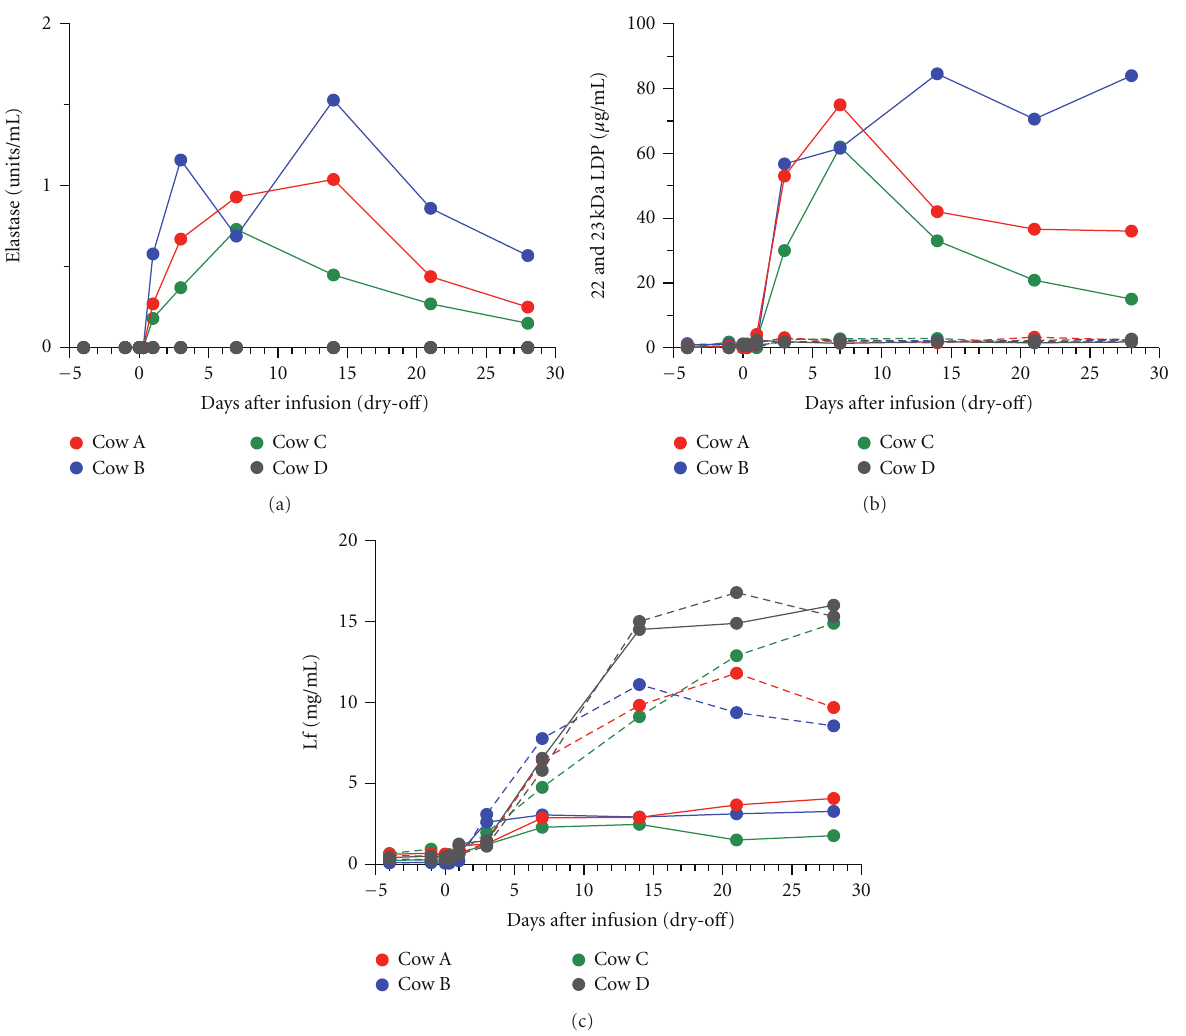
Figure 3: Changes in elastase activity (a) and the concentrations of 22 and 23 kDa LDP (b) and Lf (c) in mammary secretions from the glands infused with 50 μ g of rbIL-8 (solid line) or saline (broken line) at dry-o ff